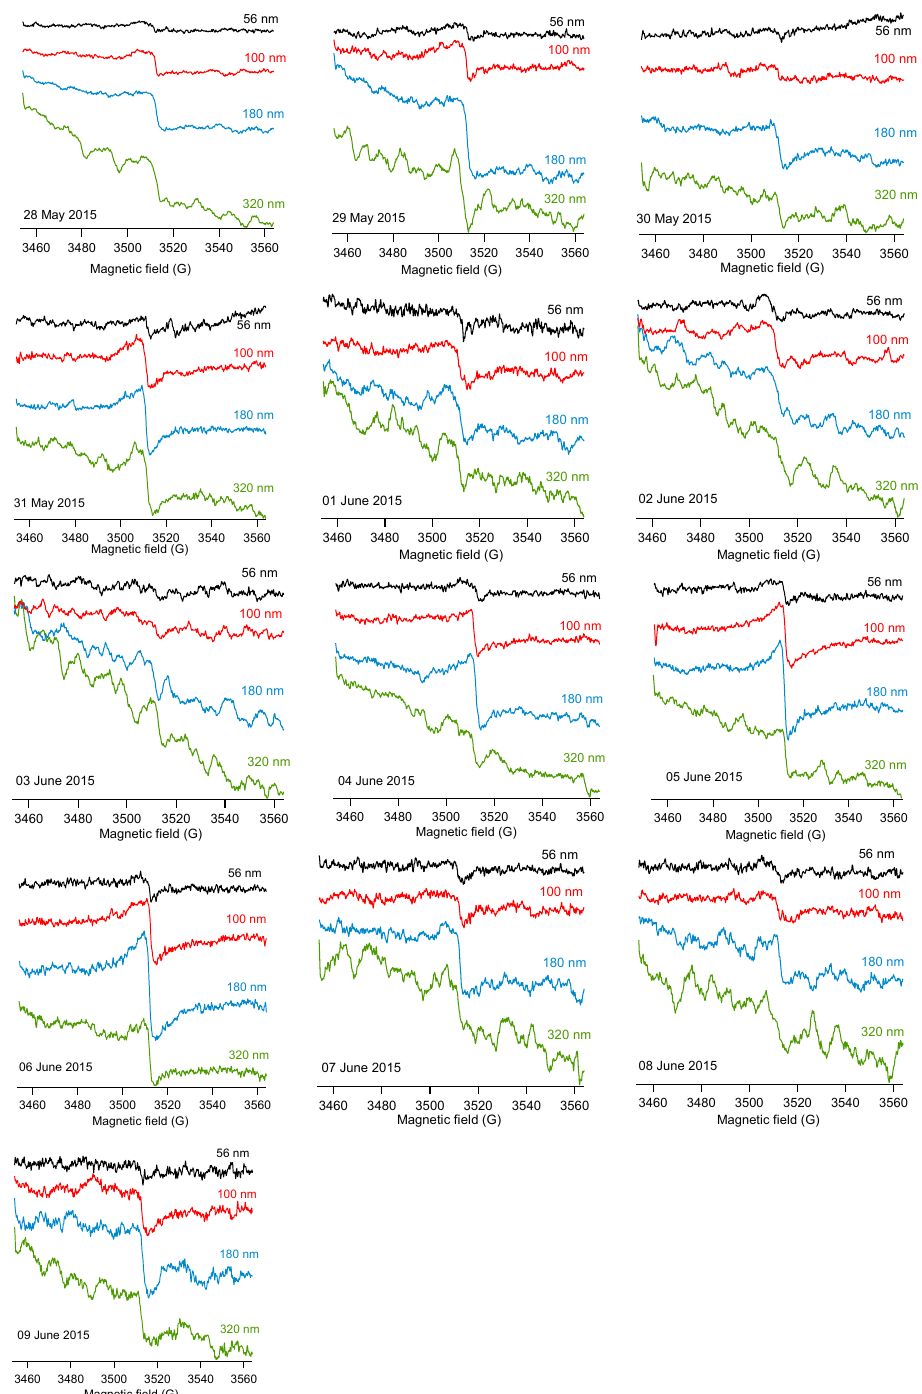
Figure A1. EPR spectra of atmospheric aerosol impactor samples with lower cut-off diameters of 56nm (black), 100nm (red), 180nm (light blue) and 320nm (green) for the measurement period during 28 May–9 June